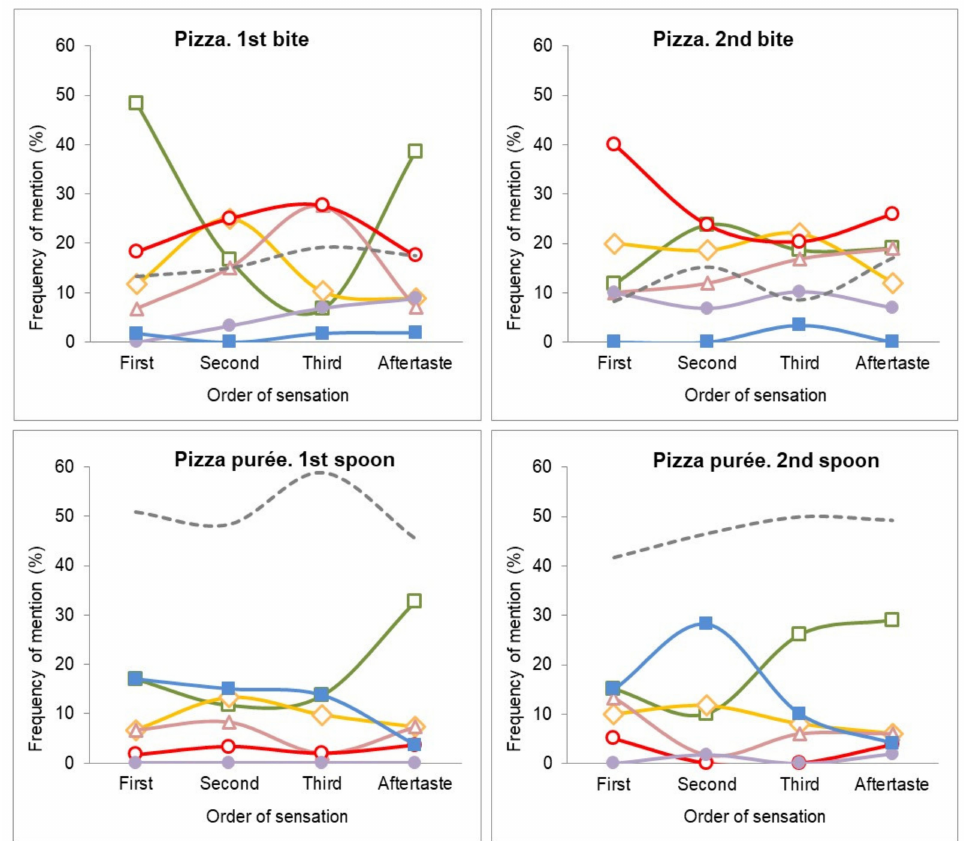
Figure 2. Free-TOS plots for the pizza dish and pizza pur é e. Frequency of the main mentioned flavors: oregano ( (cid:3) ); tomato (